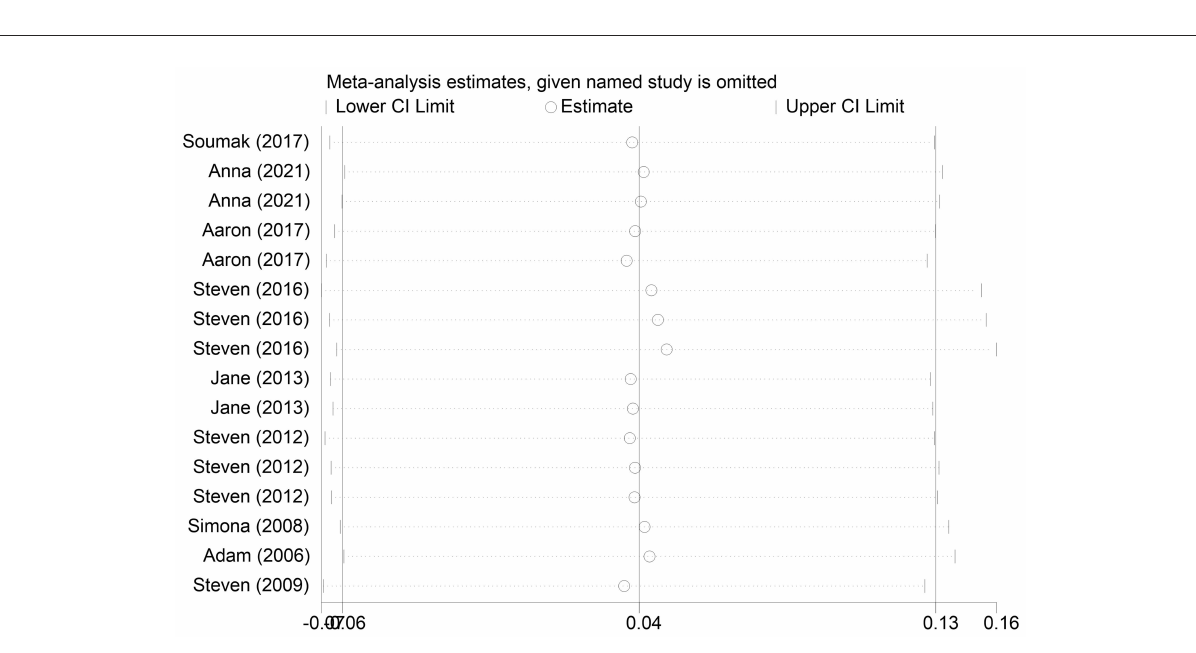
FIGURE2 Compliance sensitivity